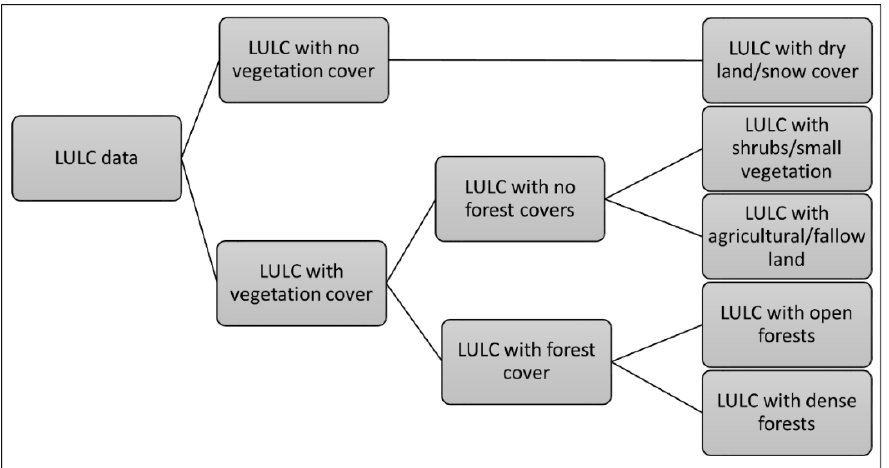
Figure 2. Hierarchy approach used for classification.